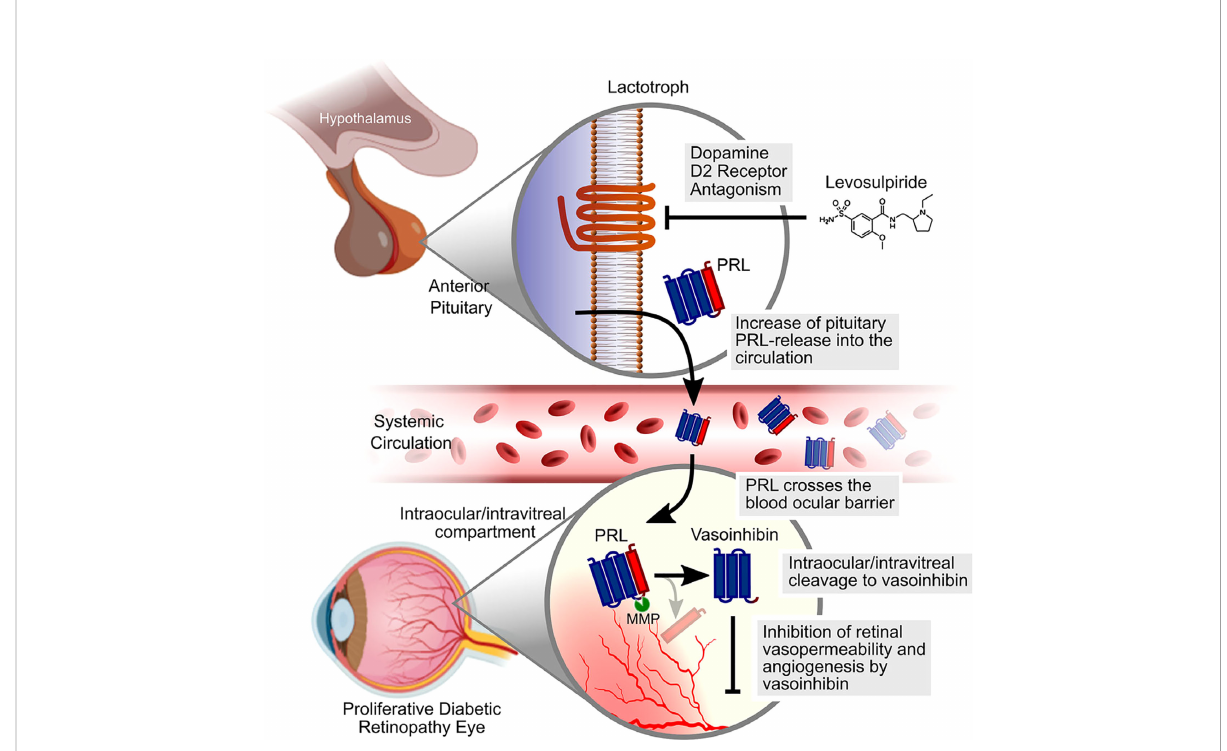
FIGURE 1 Schematic representation of the mechanism by which levosulpiride therapy could limit the progression of DME and DR. Levosulpiride, a dopamine D2 receptor antagonist, blocks dopamine D2 receptors located in the membrane of anterior pituitary cells that produce PRL (lactotrophs). Given that hypothalamic dopamine inhibits the release of PRL, levosulpiride leads to high levels of PRL in the circulation (hyperprolactinemia) which, in turn, favor PRL penetration across the blood – ocular barrier. MMPs in the intraocular/vitreous compartment cleave PRL to vasoinhibin, which can reduce retinal vasopermeability and angiogenesis in DME and DR. Scheme was partly created with Biorender.com. The original fi gure was published by Nunez-Amaro et al. (58) under the Creative Commons Attribution-Non-Commercial-NoDerivatives 4.0 International License (https://creativecommons.org/licenses/ by-nc-nd/4.0/). The fi gure was not modi fi